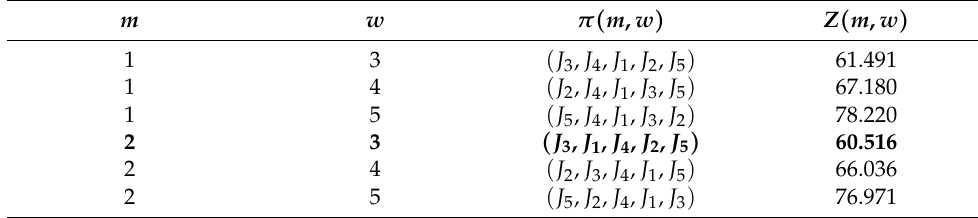
Table 7. Results of problem P 4 (bold numbers are the optimal